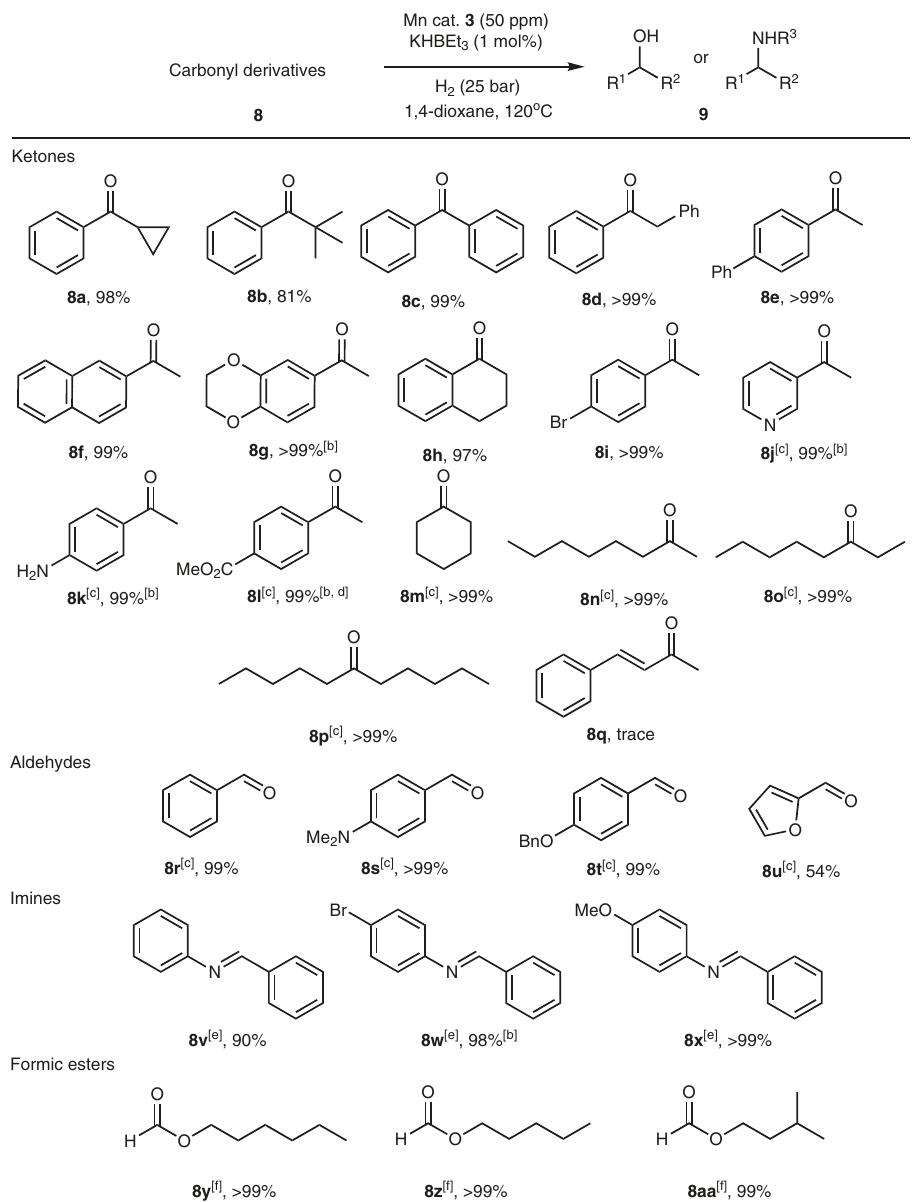
Fig. 5 Results of catalytic hydrogenation with 3. [a] Typical conditions: 5 mmol substrate, complex 3 (50 p.p.m.), KBHEt 3 (1 mol%) in 1,4-dioxane (3 mL), 120 °C, P = 25 bar H 2 , 24 h. Yields determined by GC-FID with dodecane internal standard. [b] Isolated yields. [c] Reactions carried out in isopropanol (3 mL) at 80 °C instead. [d] The product was corresponding isopropyl ester identi fi ed by NMR. [e] 100 p.p.m. of 3 used in isopropanol (3 mL), 120 °C. [f] 200 p.p.m. of 3